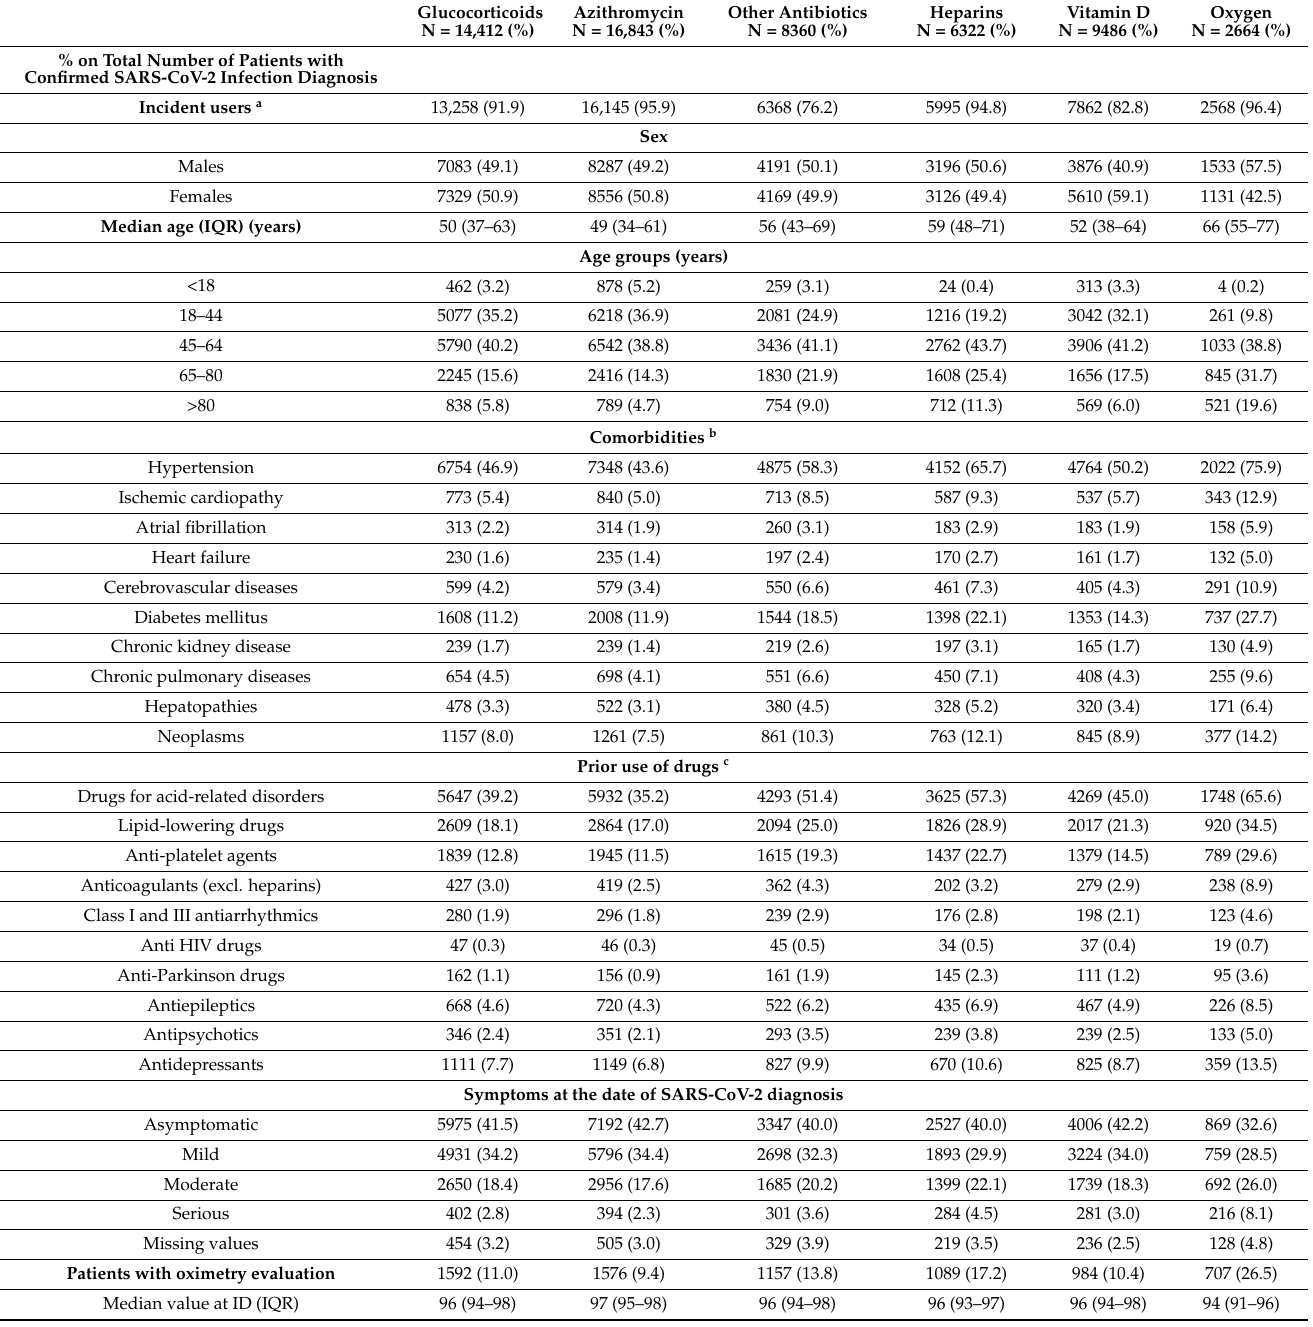
Table 1. Demographic and clinical characteristics of COVID-19 patients from Caserta Local Health Unit, stratified by the study drug, assessed at the time of SARS-CoV-2 infection diagnosis in